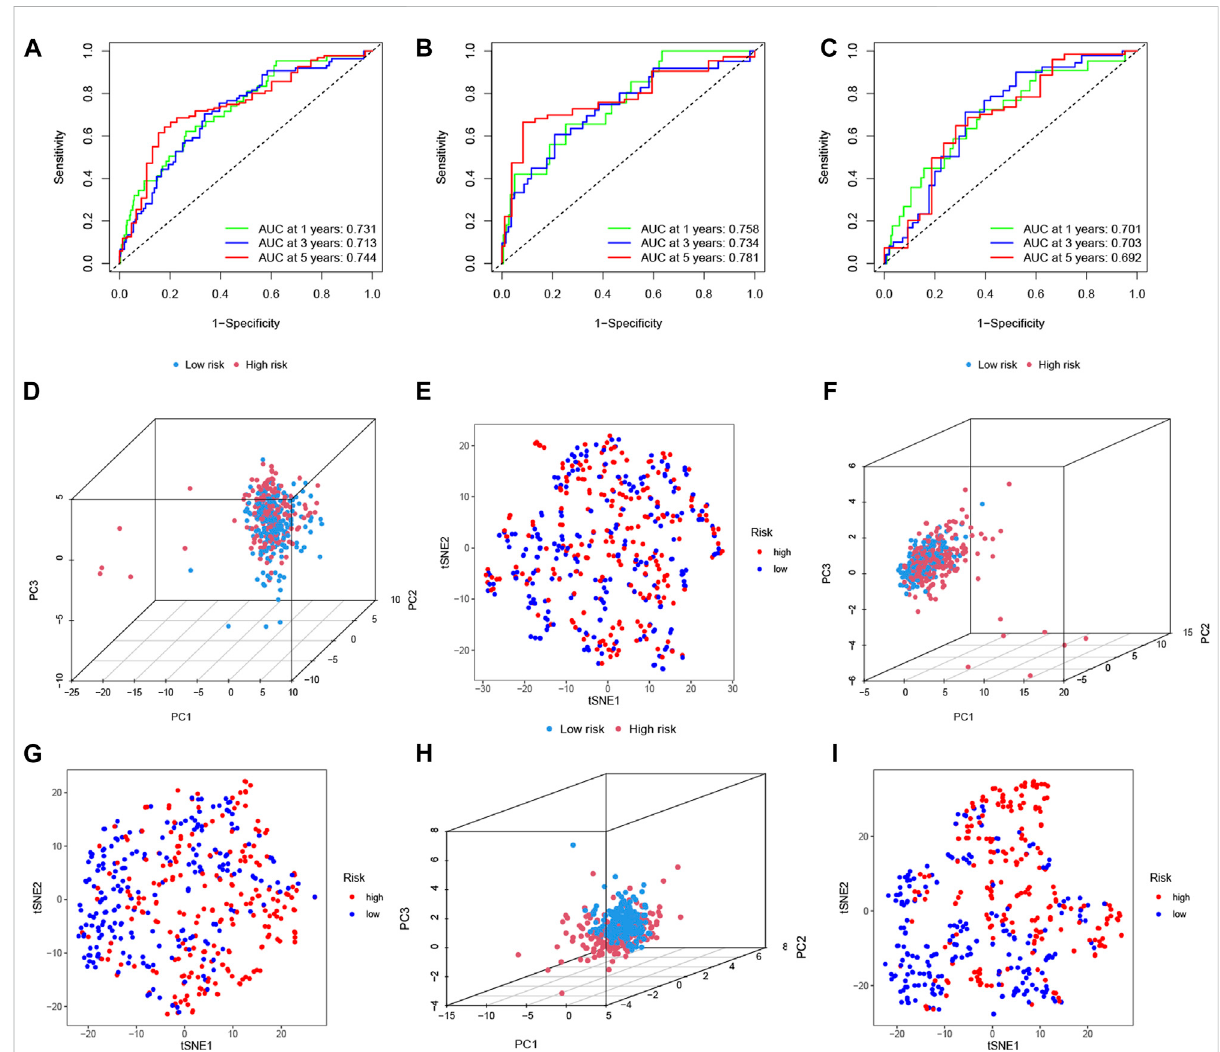
FIGURE 6 ROC, PCA, and t-SNE analysis between the high- and low-risk group. The 1-, 3-, and 5-years ROC curves of 8 m6A-related lncRNA signatures for the OS prediction in the complete dataset (A) , training (B) , and testing (C) . Principal component analysis (PCA) between the high- and low-risk groupbased on (D) 39m6Amethylationregulators, (F) 28m6A-relatedprognosticlncRNAs,and (H) 8m6A-relatedlncRNAsignatures. t-Distributed Stochastic Neighbor Embedding (t-SNE) analysis between the high- and low-risk group based on (E) 39 m6A methylation regulators, (G) 28 m6A-related prognostic lncRNAs, and (I) 8 m6A-related lncRNA